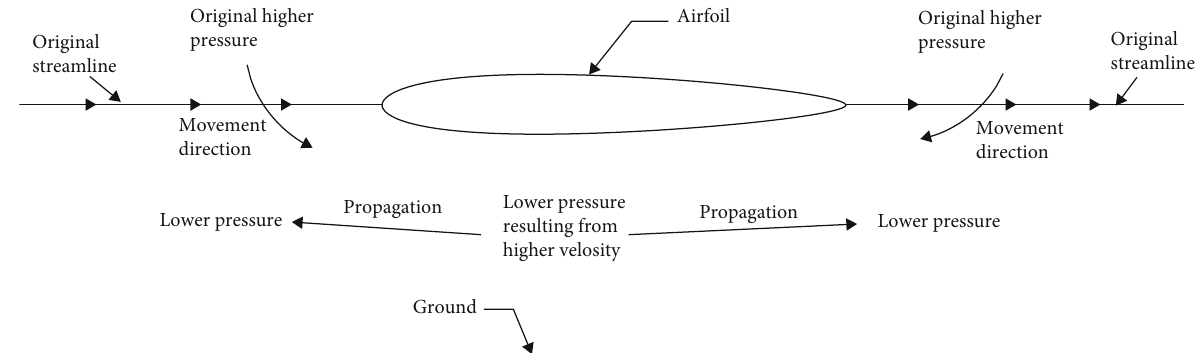
Figure 13: Principle of streamline de fl ection for the no-blowing case at α = 0 ° .